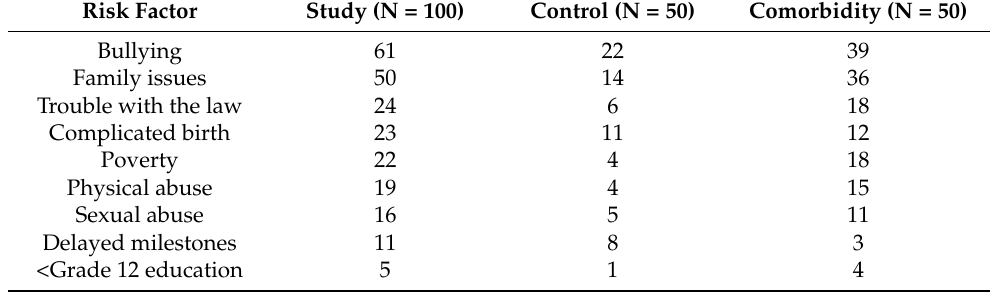
Table 2. Participant ‐ and physician ‐ reported risk factors of the study sample (N = 100).